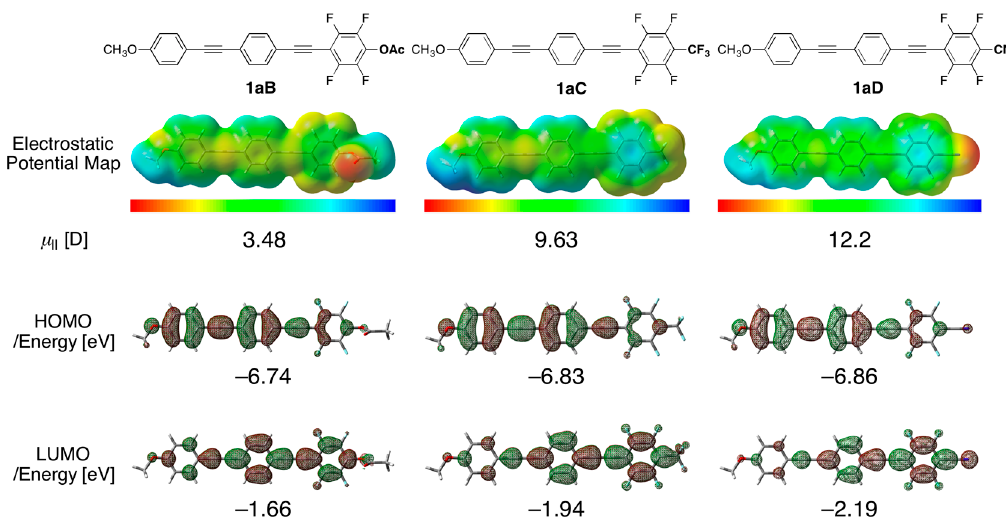
Figure 2. Chemical structures of 1aB – D and their electrostatic potential maps, dipole moments ( µ || ) along the long molecular axis, isodensity surfaces with the color-bar (isovalue = 0.0004), and orbital energies for the HOMO and LUMO in the S 1 state.